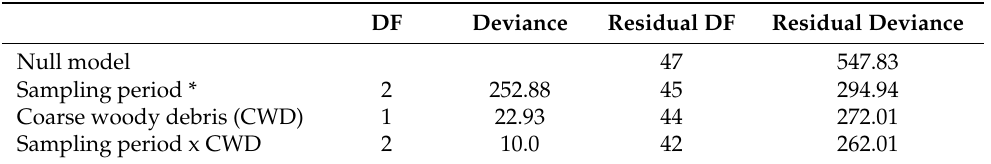
Table 4. GLM model analysis of deviance: Proportion of seeds removed by ants across time in subplots with and without coarse woody debris (CWD).